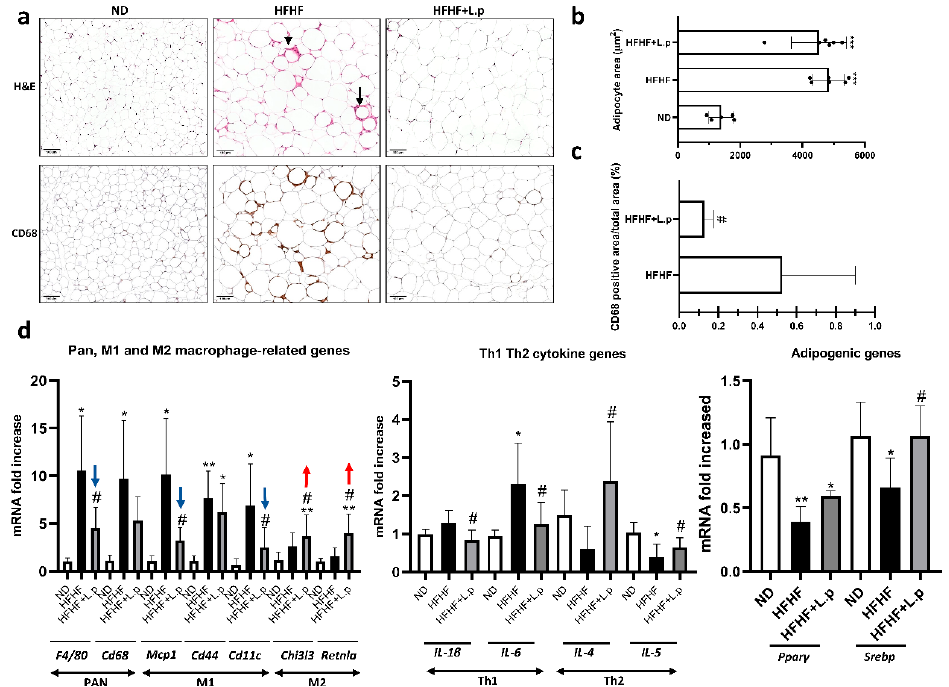
Figure 3. L.p DSM20174 supplementation reduced white adipose tissue inflammation in HFHF-fed mice. ( a ) Images of haematoxylin and eosin (H&E)-stained sections of white adipose tissue (WAT). Arrowheads indicate crown-like structures (CLS). Representative immunostaining for CD-68. ( b ) Mean adipocyte area. ( c ) CD-68 positive area (%). ( d ) Relative gene expression of the Pan, M1, and M2 macrophage markers; Th1 and Th2 cytokines; and adipogenic genes. All genes were normalised to expression of RPLPO. Blue arrows indicate decreased M1 macrophage marker expression, whereas red arrows show increased M2 macrophage marker expression. Data are expressed as mean ±